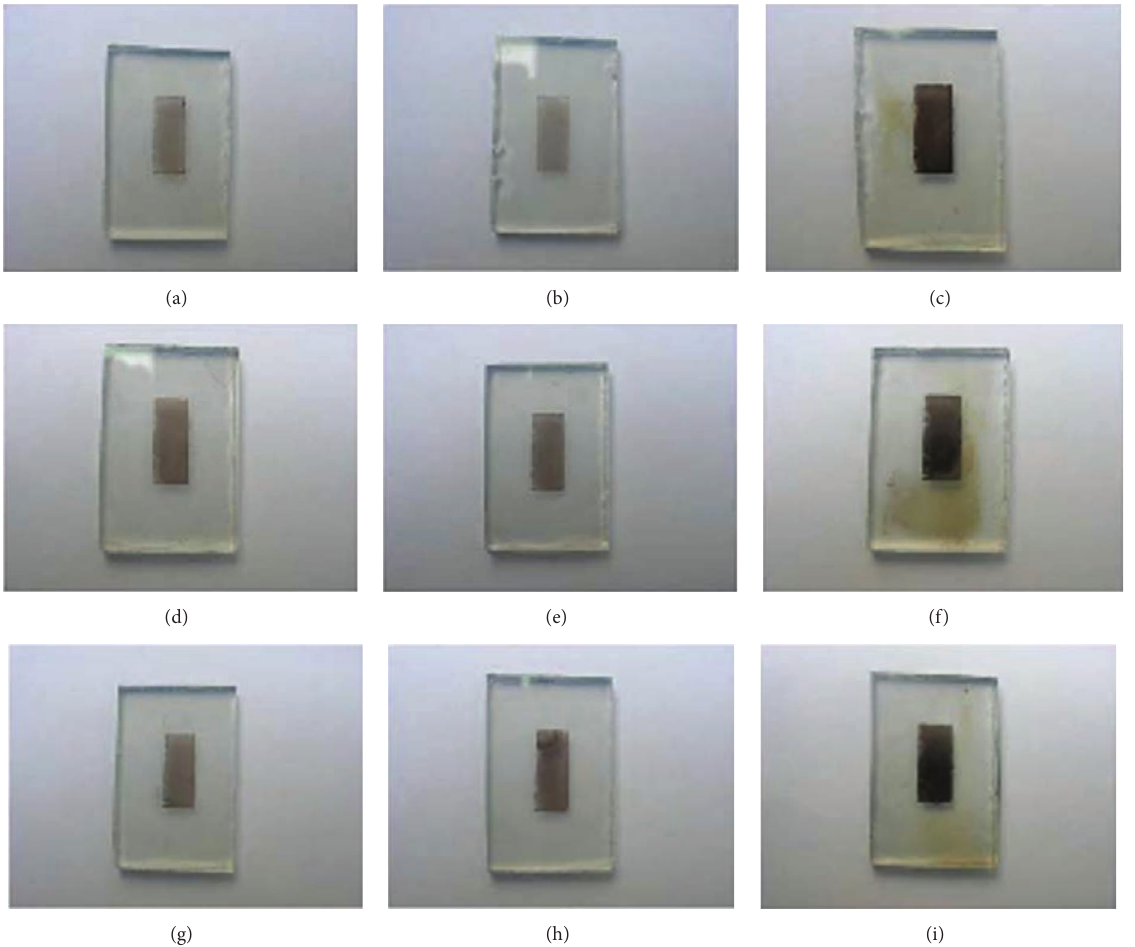
Figure 3: The TiO 2 /MgO/Ag composite films with varied magnesium acetate solution concentrations and silver nanoparticles sizes: (a) TiO 2 /MgO (0.08 nm)/Ag (4.4nm), (b) TiO 2 /MgO (0.10nm)/Ag (4.4nm), (c) TiO 2 /MgO (0.46 nm)/Ag (4.4 nm), (d) TiO 2 /MgO (0.08 nm)/Ag (19.2 nm), (e) TiO 2 /MgO (0.10nm)/Ag (19.2nm), (f) TiO 2 /MgO (0.46nm)/Ag (19.2nm), (g) TiO 2 /MgO (0.08 nm)/Ag (38.6 nm), (h) TiO 2 /MgO (0.10nm)/Ag (38.6 nm), and (i) TiO 2 /MgO (0.46 nm)/Ag (38.6